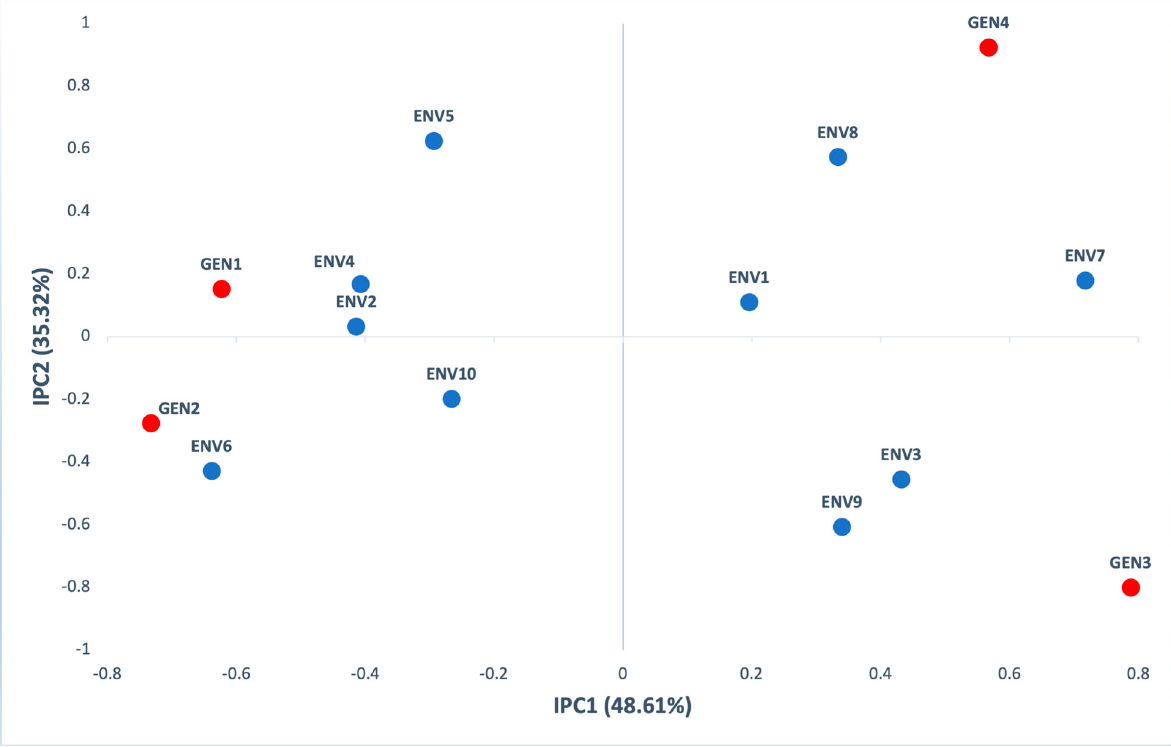
Figure 5. AMMI biplot presenting the second interaction principal components axis (IPC2) against the first interaction principal components axis (IPC1) scores for protein content of 4 genotypes (red) evaluated in 10 environments (blue).